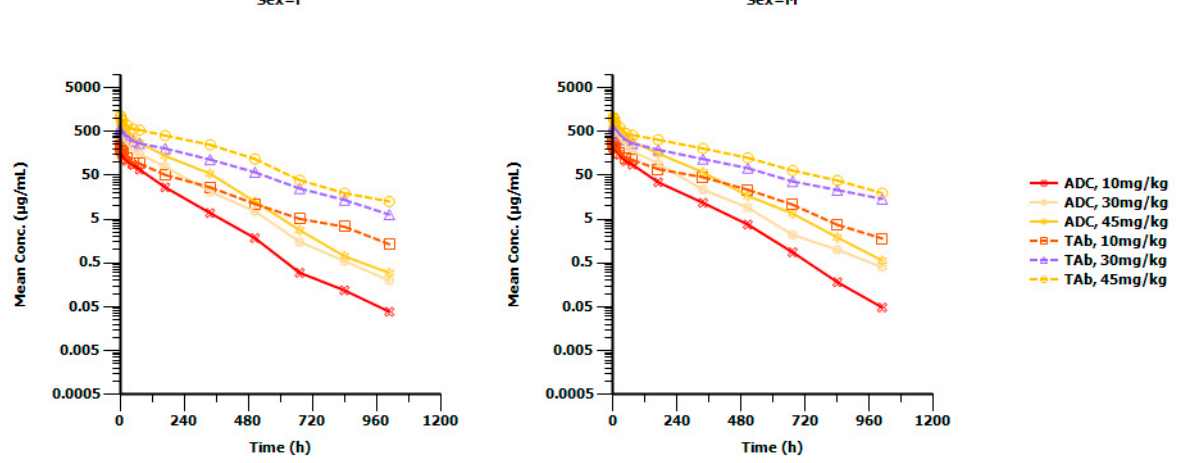
Figure 3. Mean serum concentration–time curves and results after a single intravenous infusion of GQ1001 in cynomolgus monkeys. The figures depict the cumulative concentration of GQ1001 in the serum of cynomolgus monkeys that were randomly assigned into 4 groups (3/gender/group) following single intravenous infusions of 10, 30 and 45 mg/kg GQ1001. Sampling time points include pre-dose (0 h), and 5 min, 1 h, 4 h, 8 h, 24 h, 48 h, 72 h, 168 h, 336 h, 504 h, 672 h, 840 h, 1008 h post dose. Table 6. Final reported titer results of anti-drug antibody test after intravenous infusions of GQ1001 to cynomolgus mon- keys.